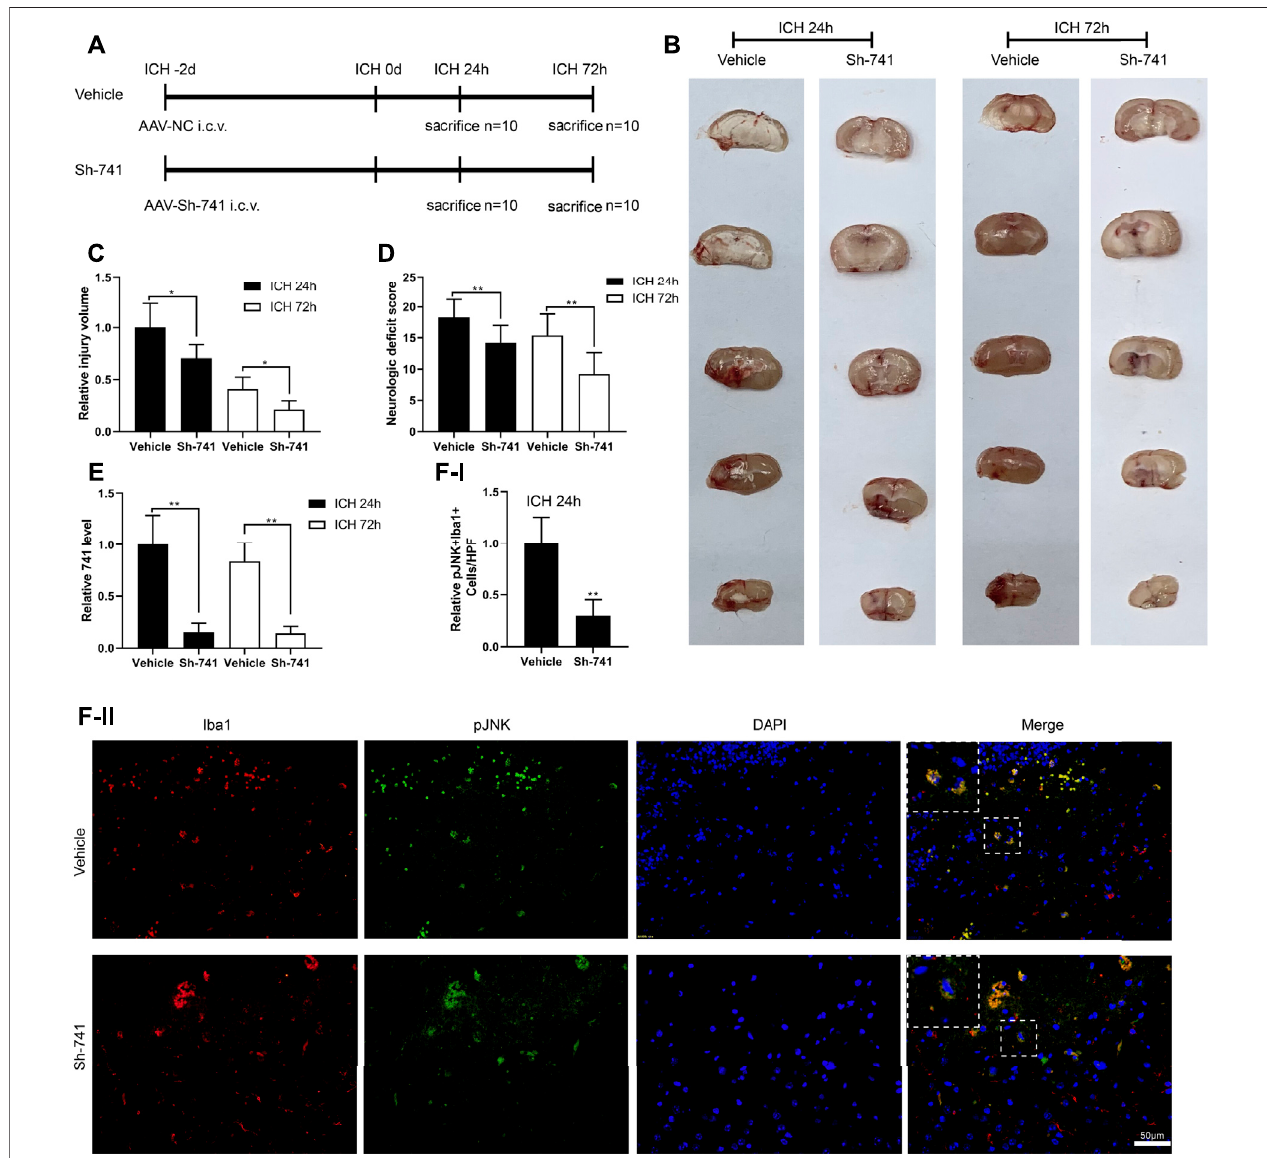
FIGURE 6 | Effect of TCONS_00145741 on the degree of a cerebral hemorrhage in mice. (A) The experimental scheme for the construction of the mouse ICH model, n (cid:2) 10. (BandC) Analysisoftheinjuryvolumeinmice,n (cid:2) 10. (D) Analysisoftheneurologicde fi citscore,n (cid:2) 10. (E) DetectionofTCONS_00145741expression by qRT-PCR, n (cid:2) 10. (F) Detection of the pJNK using immuno fl uorescence, n (cid:2) 10, (Scale bar (cid:2) 50 μ m). * p < 0.05, ** p < 0.01 vs. vehicle. Sh-741: shRNA TCONS_00145741.